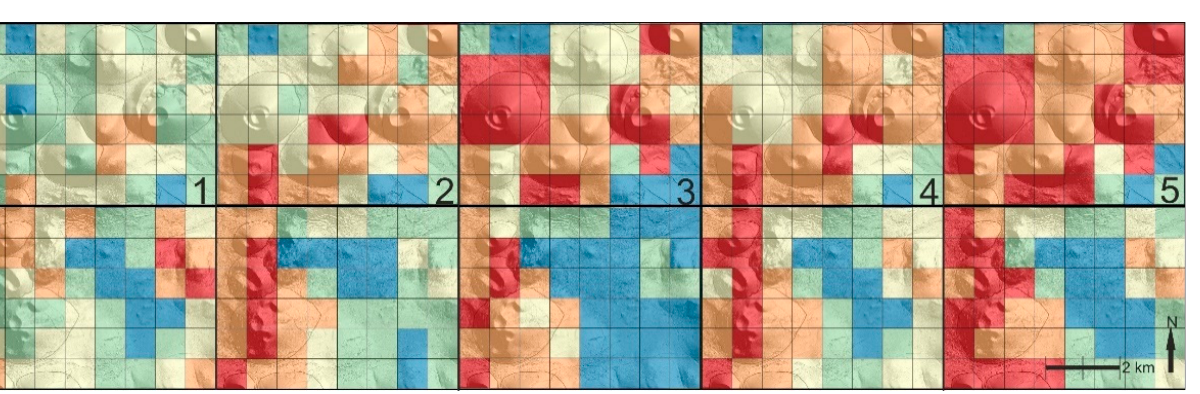
Figure 12. Two example areas of the examined area: ( a ) Puy de Côme and its surrounding area (top row); ( b ) Puy de Montchié (bottom row) and its surrounding area. The numbers refer to the map (Figures 8–10) from which the cutout was made (see above).